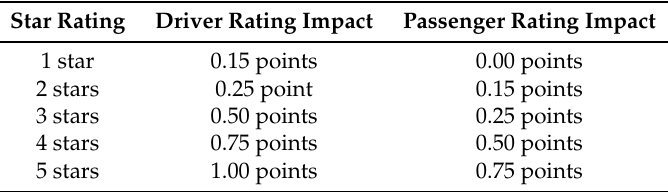
Table 2. Impact of the